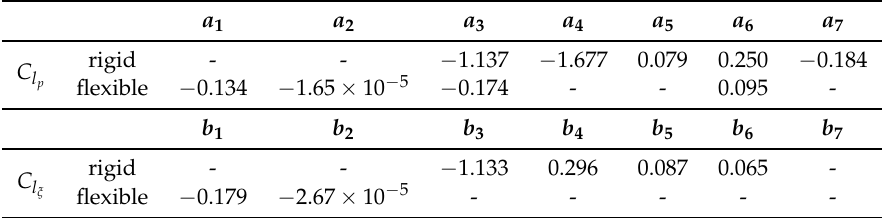
Table 2. Prediction model